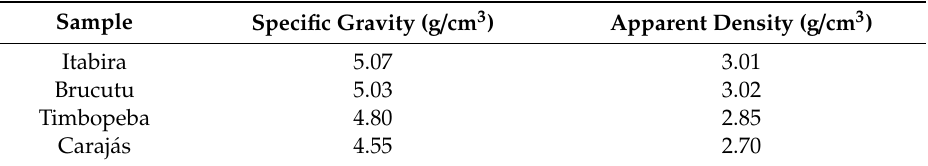
Table 1. Summary of physical characteristics of the samples.